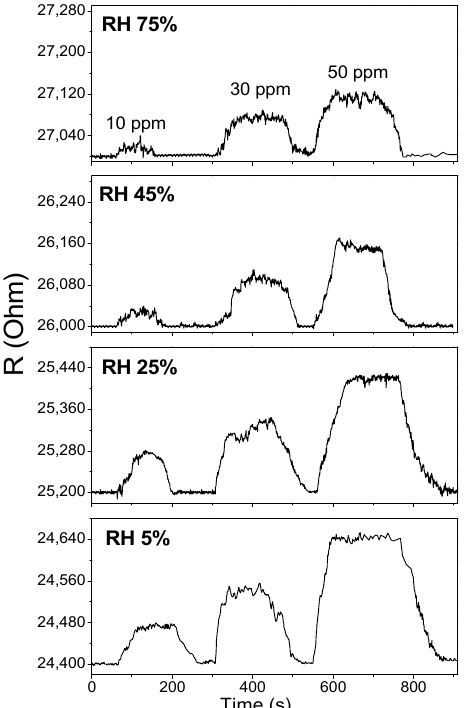
Figure 9. Sensor response of SWCNT/SiPc hybrid layers toward NH 3 (10, 30 and 50 ppm) measured at RH 5, 25, 45 and 75% and 25 °C.